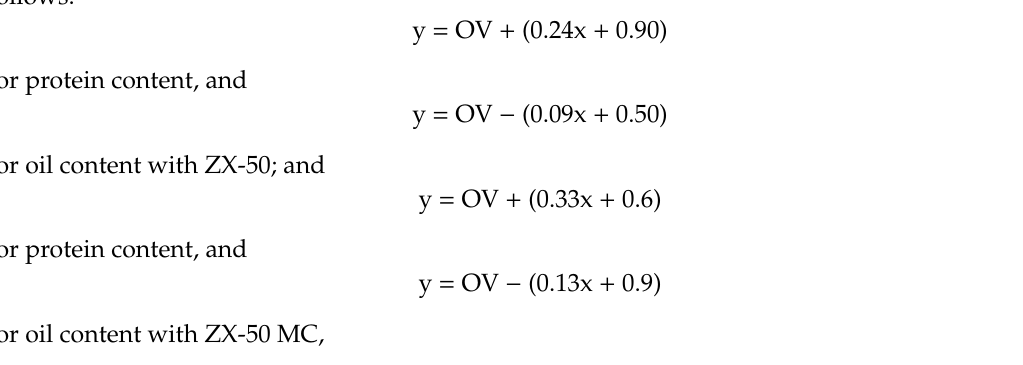
(Table 3). Di ff erences between two extreme observations for a single genotype averaged 2.50 g 100 − 1 − 1 g for seed protein content and 1.48 g 100 g for oil content. In addition, the di ff erences in protein content between two extreme observations for a single genotype averaged 1.66 g 100 g − 1 and 1.30 g 100 g for ZX-50 MC, which were smaller than that with DA 7250 (2.50 g 100 g content, the di ff erences between two extreme observations with a single genotype averaged 1.71